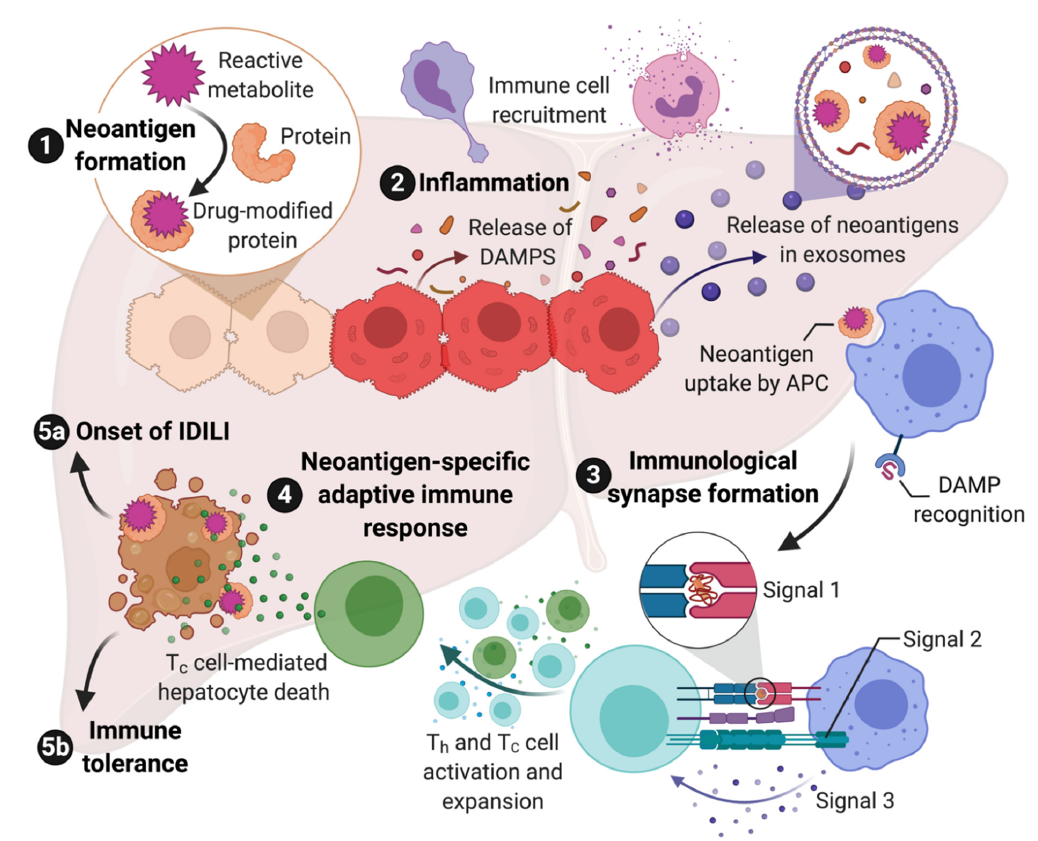
Figure 1. Proposed general mechanism of idiosyncratic drug-induced liver injury (IDILI). The following are the